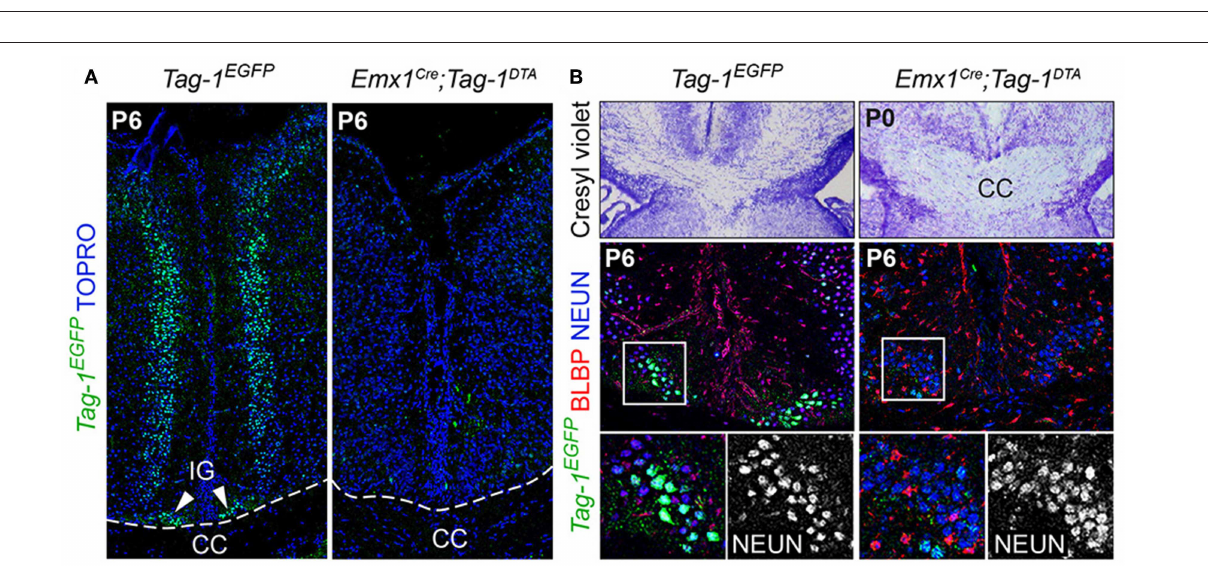
FIGURE 10 | Emx1-Cre mediated ablation of TAG-1 + cells of the indisium griseum does not affect the guidepost cells of the corpus callosum. (A) Immunofluorescent analysis of Tag-1 EGFP at P6 in Tag-1 EGFP and Emx1 Cre ;Tag-1 DTA mice shows the ablation of a Tag-1 EGFP + cellular population at the midline (indusium griseum - IG). (B) Morphological staining and immunofluorescent analysis against Tag-1 EGFP , BLBP and NEUN show no defect following the ablation of the Tag-1 EGFP + neuronal population at the midline in the vicinity of the corpus callosum. IG, induseum griseum, CC, corpus